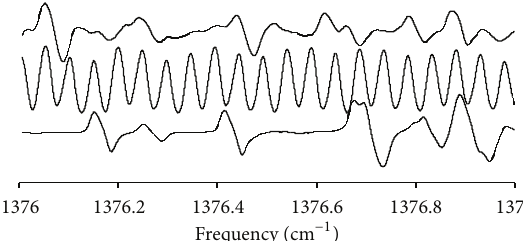
Figure 4: High resolution scan obtained with an isobutylene vapor sample at a total pressure of 80mTorr in a 75 m Herriott cell. The top trace is the signal channel containing the isobutylene sample. The middle trace is an interference pattern generated by a solid Ge etalon.Thelasttraceisduetomethylchloride.Againthebottomtwo traces are collected for calibration purposes with the etalon being used to transform the time-based signal into cm −1 /point and the reference gas channel providing an absolute position in frequency space.